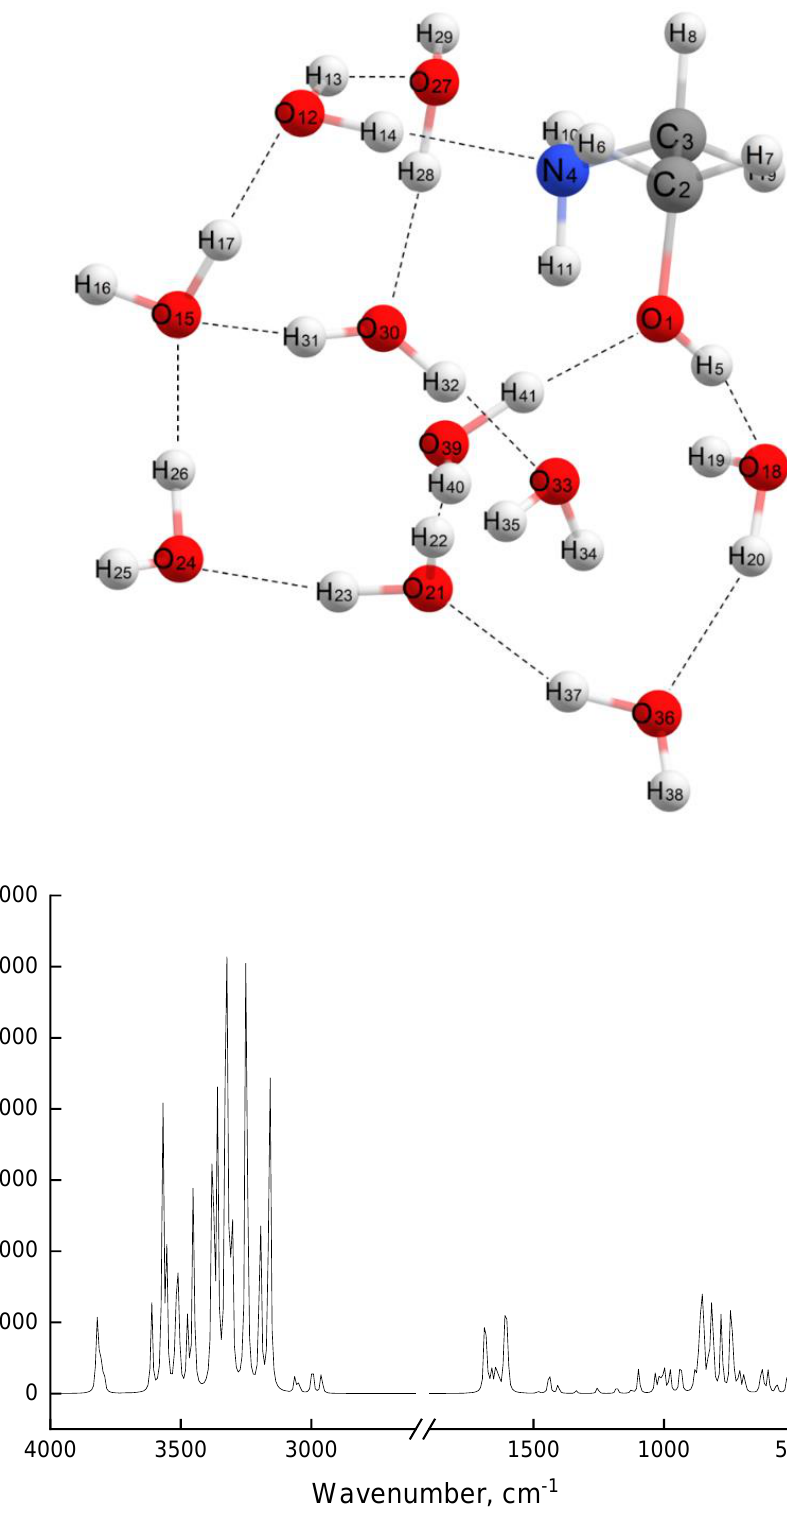
Figure 5. Model of MEA-10 H 2 O complex and theoretical IR spectrum of MEA-10H 2 O model. The MEA molecule is also included in the hydrogen bonding system, with the short- est hydrogen bond, 1.693 Å, occurring between the O1 oxygen atom of MEA and the H41 hydrogen atom of the nearest water molecule. The MEA nitrogen atom is also linked to the H14 hydrogen atom from a water molecule via a 1.891 Å hydrogen bond. The entire associate complex is a three-way cycle, in which two cycles are composed exclusively of alternating valence and hydrogen O-H bonds of water molecules, and the distances be- tween two oxygen atoms not bound by hydrogen bonds in these cycles are in a range 4.2 – 4.5 Å. The third cycle includes five associated water molecules and a MEA molecule. In this cycle, rather short distances (2.7 Å) between oxygen О1…О18 and О1…О39 atoms are realized. Notably, between Н11 and О33 atoms, there is an internal hydrogen bond (2.5 Å). Despite the complexity of its structure, this associate has fairly high symmetry and